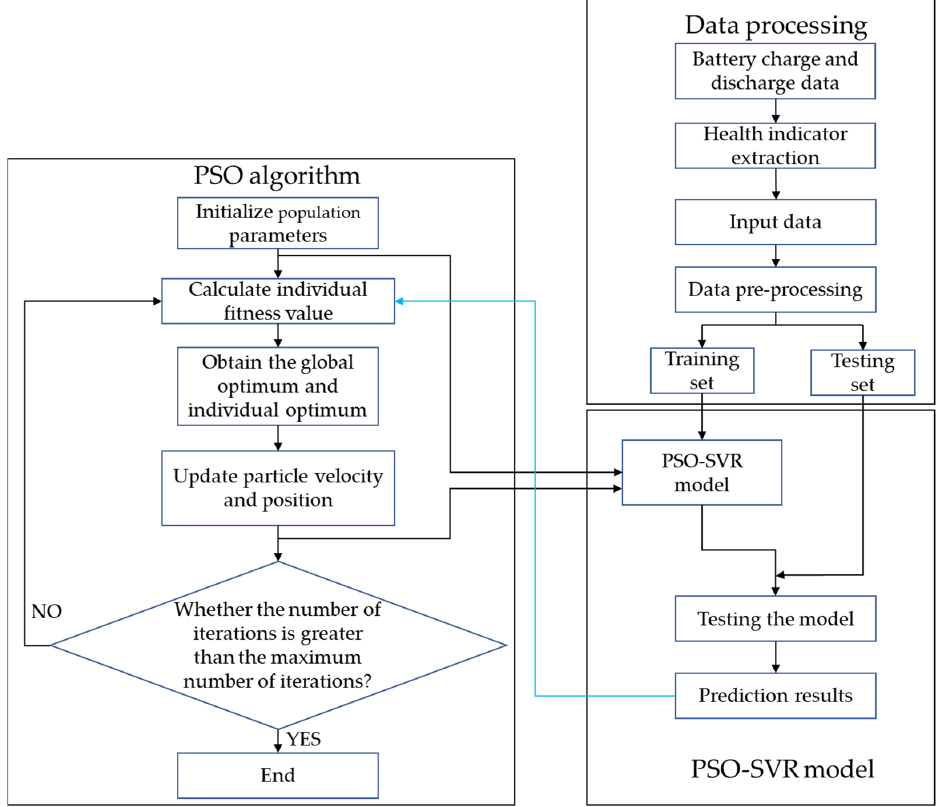
Figure 1. Flowchart of the PSO–SVR method.